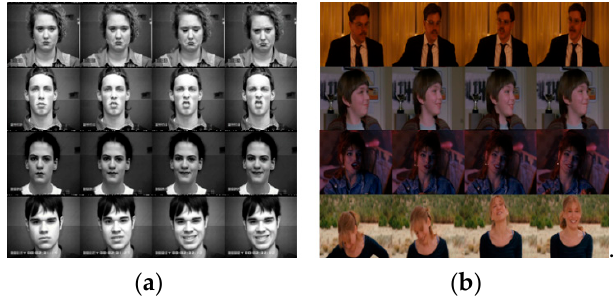
Figure 1. ( a ) CK+ dataset in a limited environment; ( b ) AFEW dataset in a wild environment. Figure 1. ( a ) CK + dataset in a limited environment; ( b ) AFEW dataset in a wild